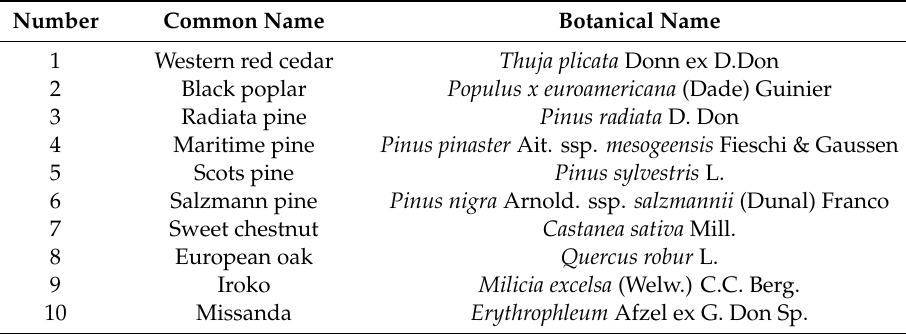
Table 1. Common and Botanical names of wood species tested.